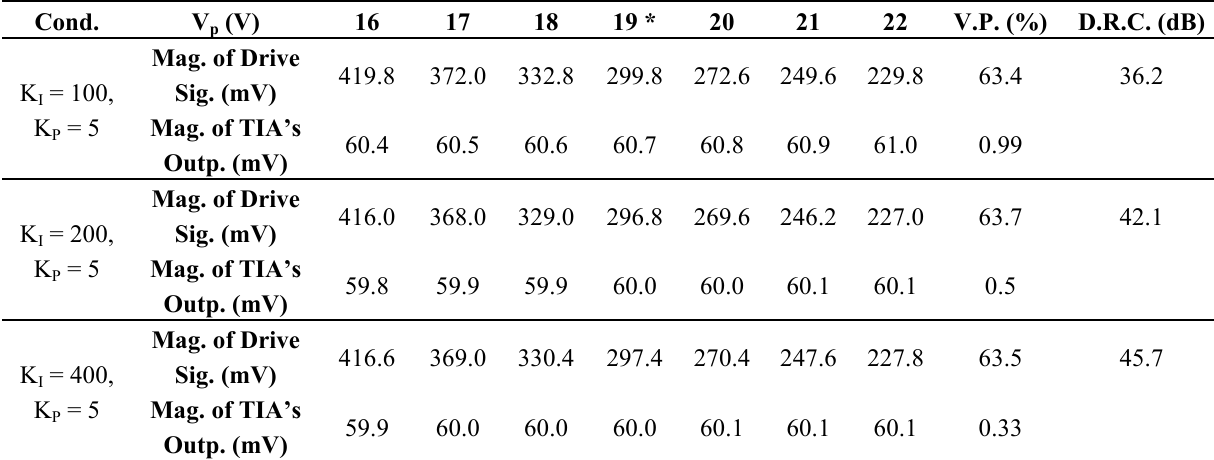
by varying V . I p